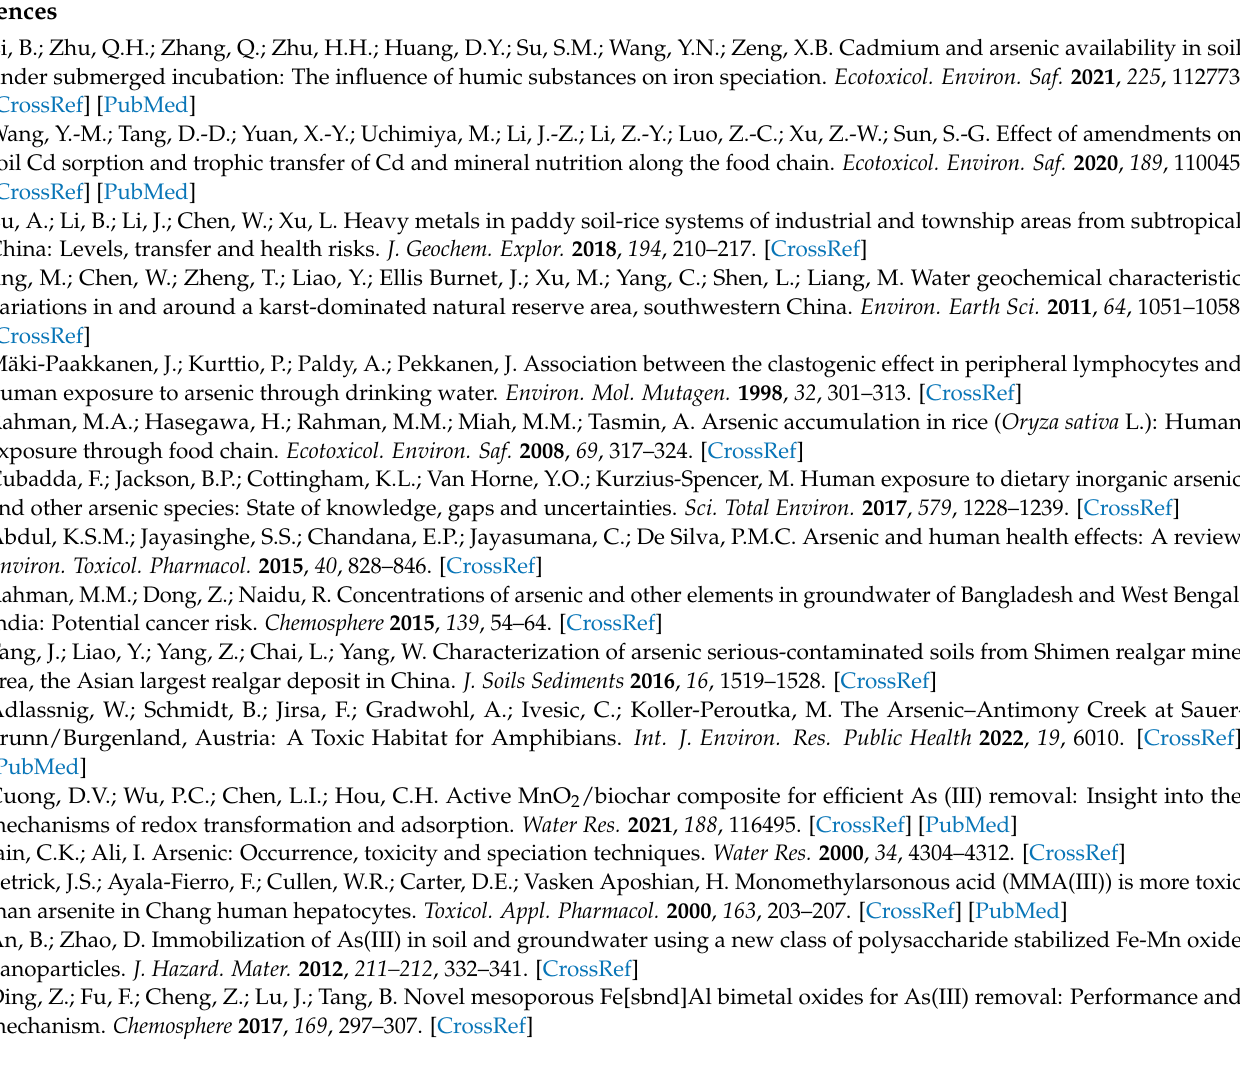
Table S2: Fitting results of As(III) and As(V) adsorption on nZVI and S-nZVI by Dubinin–Astakhov model (a–d) and Dubinin–Radushkevich